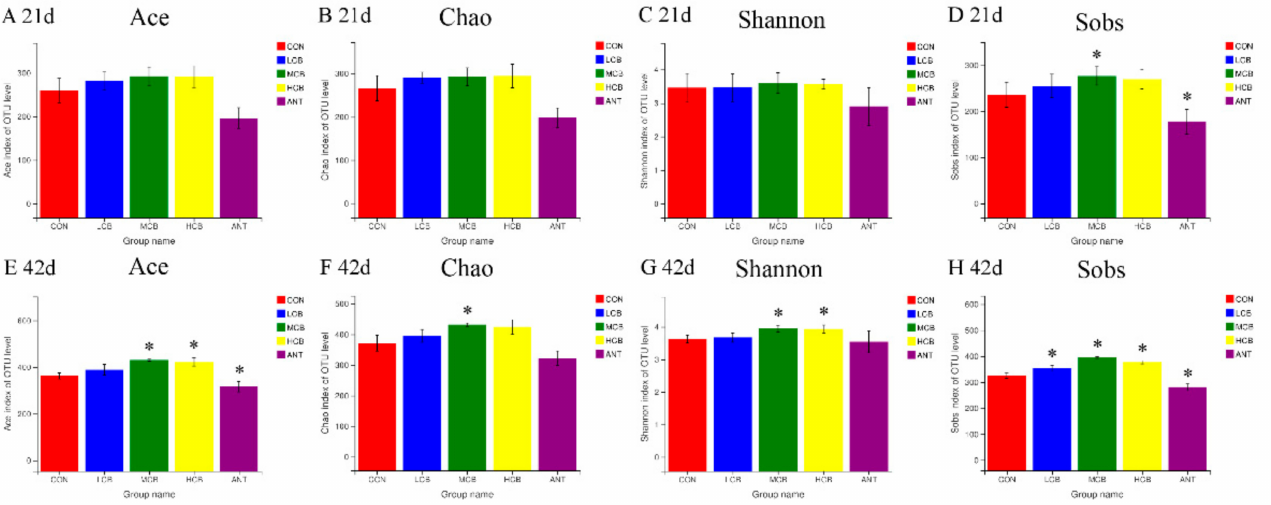
Figure 6. Estimators of α -diversity indices in ceca of Pekin ducks in the five groups at different timepoint. ( A ), Ace index at 21 d; ( B ), Chao index at 21 d; ( C ), Shannon index at 21 d; ( D ), Sobs index at 42 d; ( E ), Ace index at 42 d; ( F ), Chao index at 42 d; ( G ), Shannon index at 42 d; ( H ), Sobs index at 42 d. The superscript * indicates that there are significant differences ( p < 0.05) compared with the control group. CON, group Con; LCB, group CB200; MCB, group CB400; HCB, group CB600; ANT, group